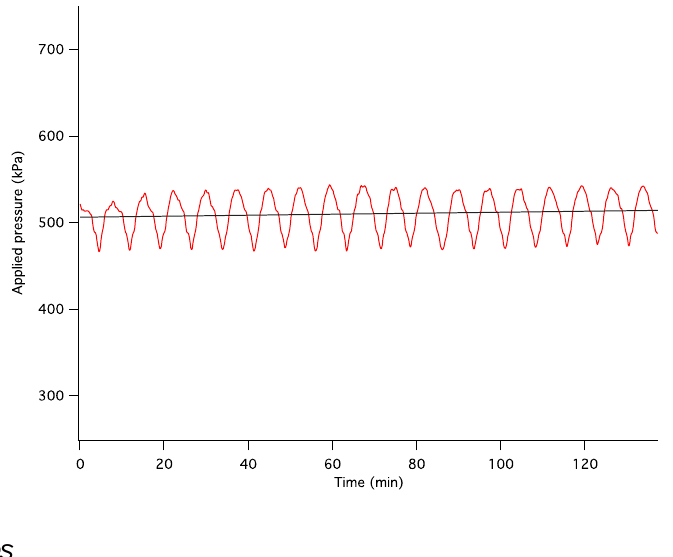
Figure 6. A representative plot showing the fluctuations in the supplied air pressure vs. time consistent with the fluctuations of the applied pressure shown in Figure 5 being an artifact of the compressed air supply.